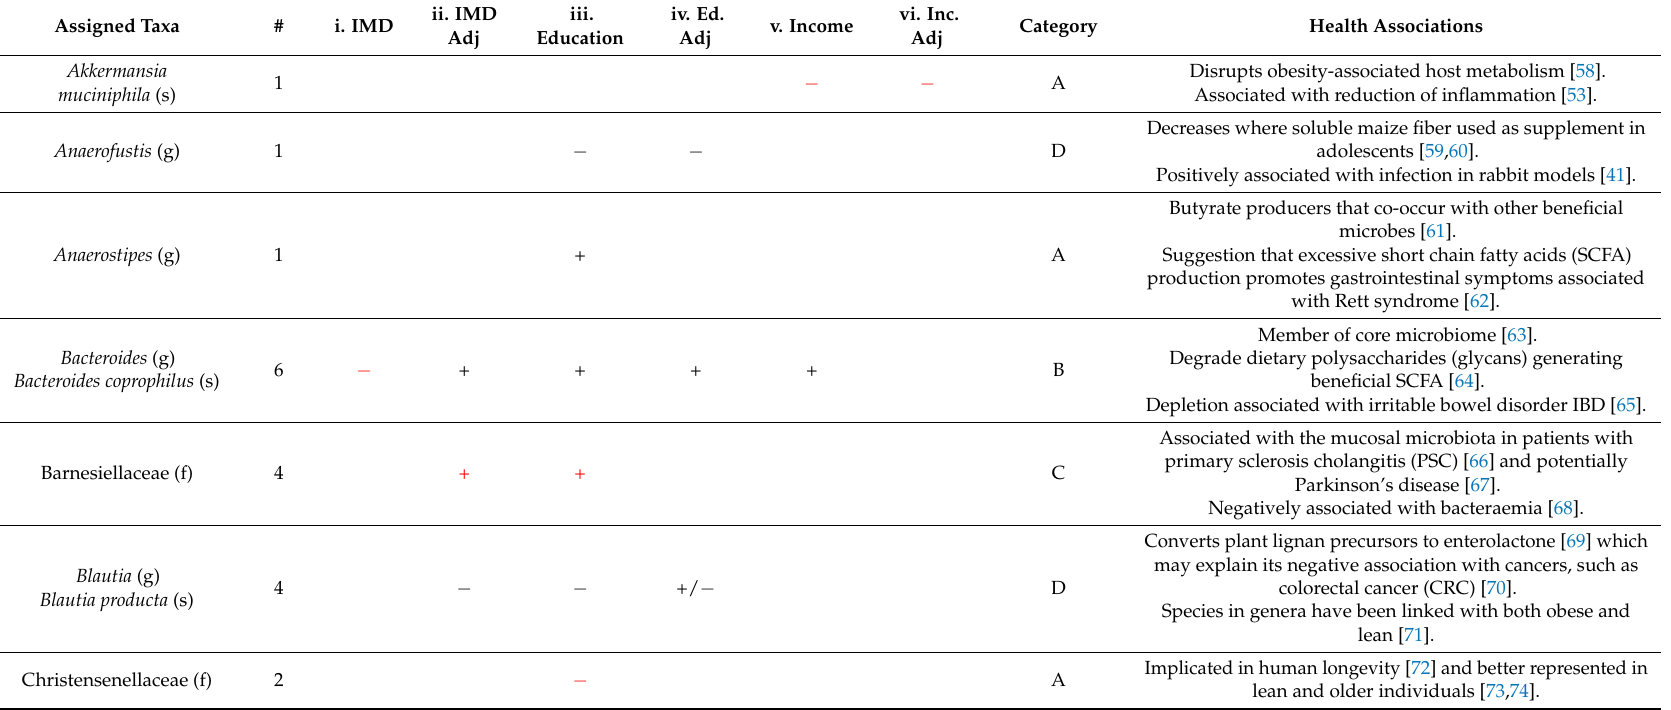
Table 2. Summary of taxa assigned to OTUs found to be differentially abundant between the most-deprived and least-deprived measures of socioeconomic status in at least two models. Only taxa with multiple OTUs assigned to it, or with multiple SES factors associated with it, and with q -value < 0.01 are discussed. OTUs relatively enriched in the least deprived compared to highest for each SES variable are indicated with (+); those enriched in the most deprived compared to the least indicated with ( − ); where multiple directions of association were observed, this is indicated with (+/ − ). The lowest assigned taxa level is indicated; number of OTUs assigned within this taxa at the lowest level is included. Categories refer to the current general consensus of the genera’s relationship with health where (A) generally positive health associations, (B) generally positive health associations, but opportunistic pathogens, (C) generally negative health associations, and (D) paraphyletic taxa/mixed consensus/not enough information. Where relationships are shown in red, they are contrary to the literature consensus on direction of health association. Assigned